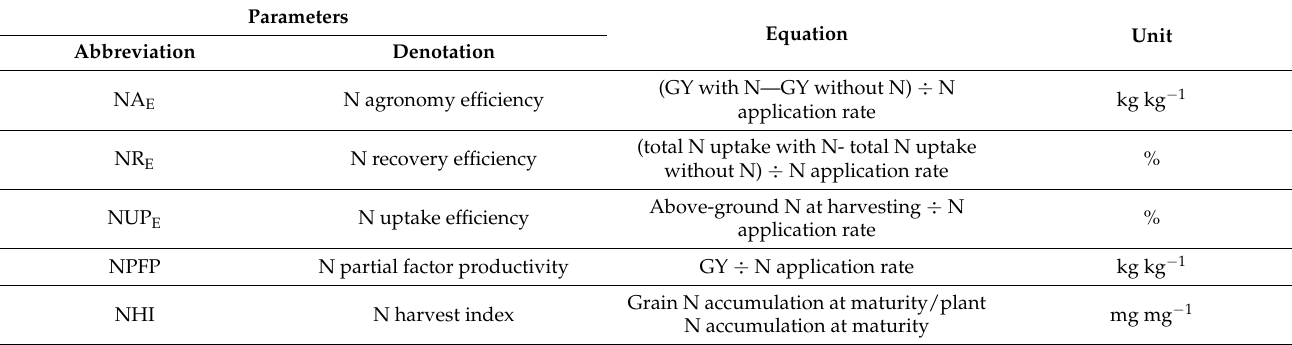
Table 9. Equations for estimating NU E